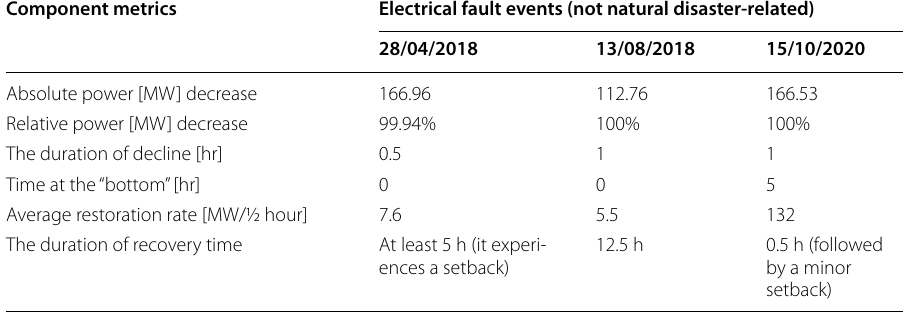
Table 2 Result overview for climate resilience components during electrical fault events Component metrics